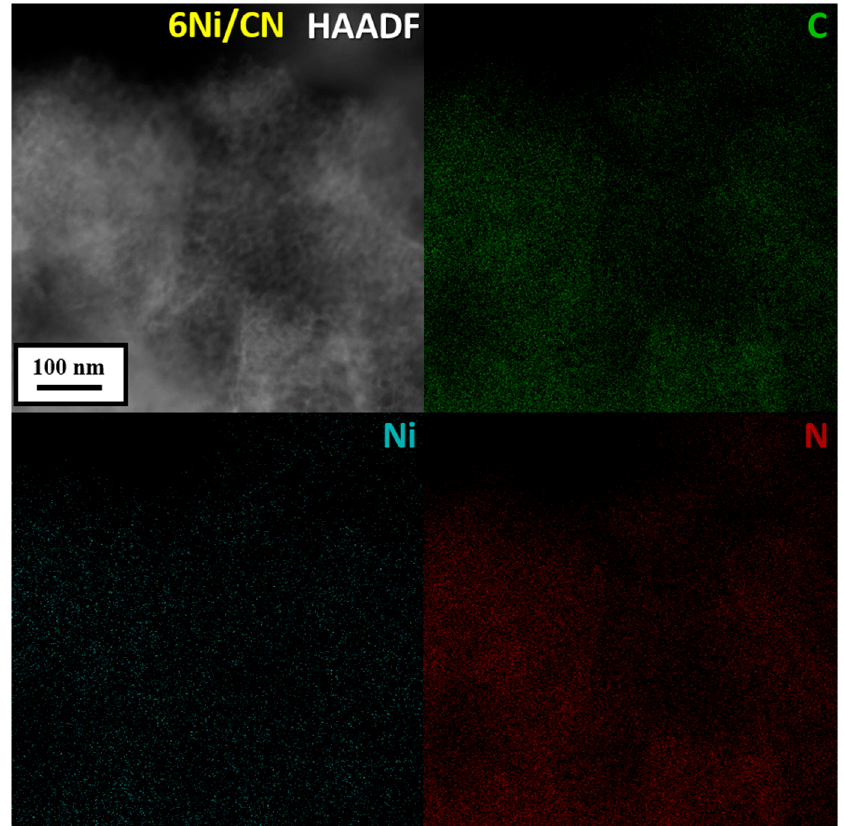
Figure 2. HAADF/STEM image and corresponding elemental mapping of C, Ni and N in the 6Ni/CN nanomaterial after the catalytic reaction.